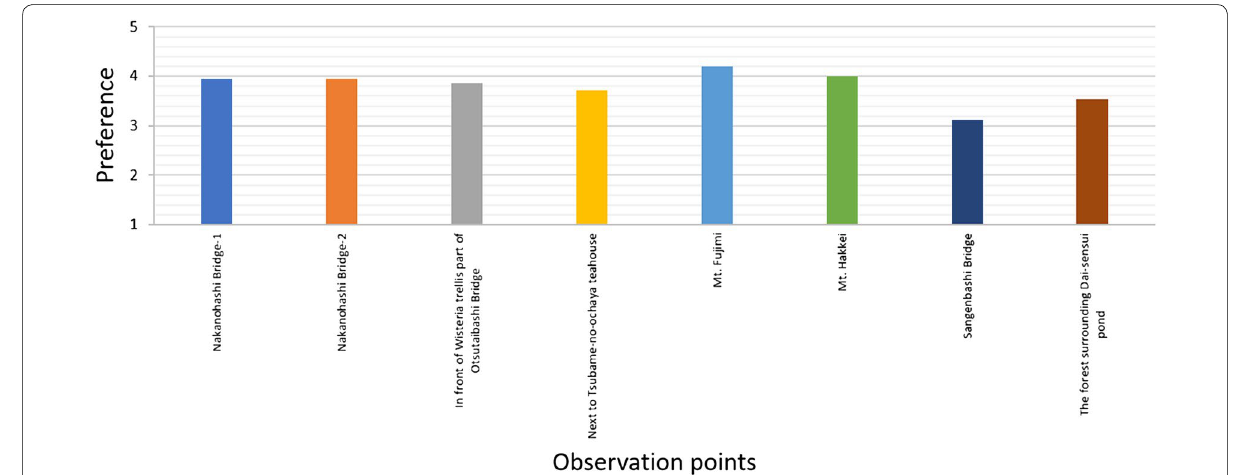
Fig. 3 Mean preference scores of the